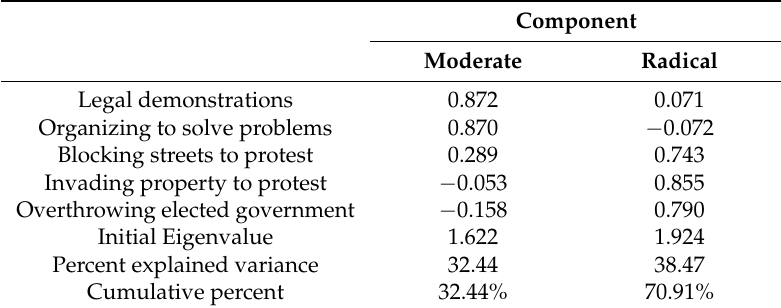
Table 1. Factor analysis for support for different protest